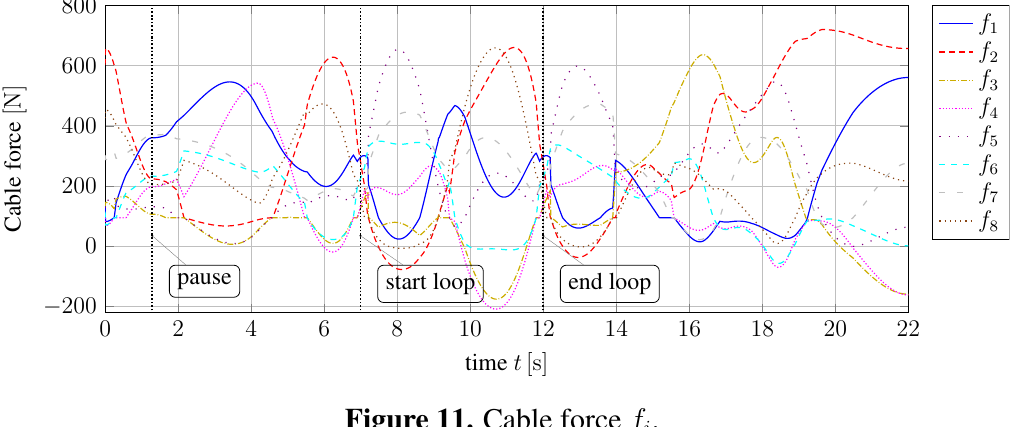
Figure 11. Cable force f i .